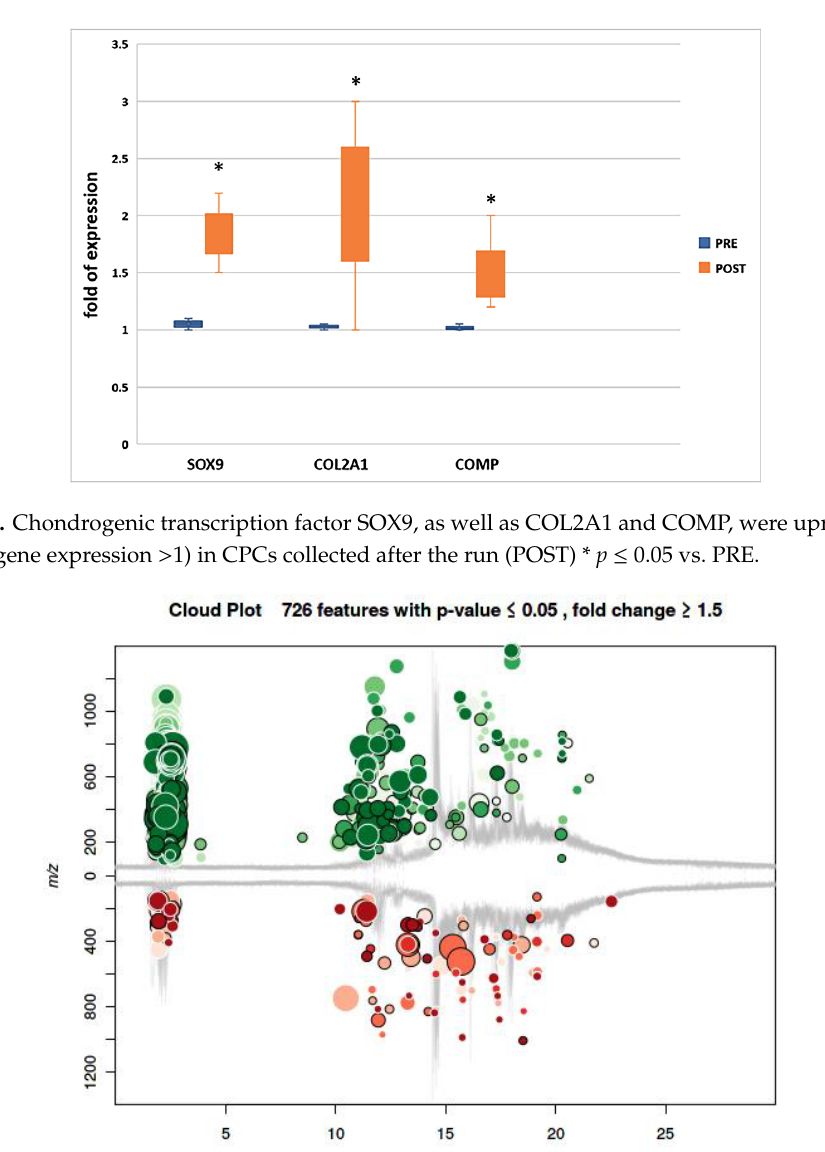
Figure 1. Chondrogenic transcription factor SOX9, as well as COL2A1 and COMP, were upregulated (fold of gene expression >1) in CPCs collected after the run (POST) * p ≤ 0.05 vs. PRE .